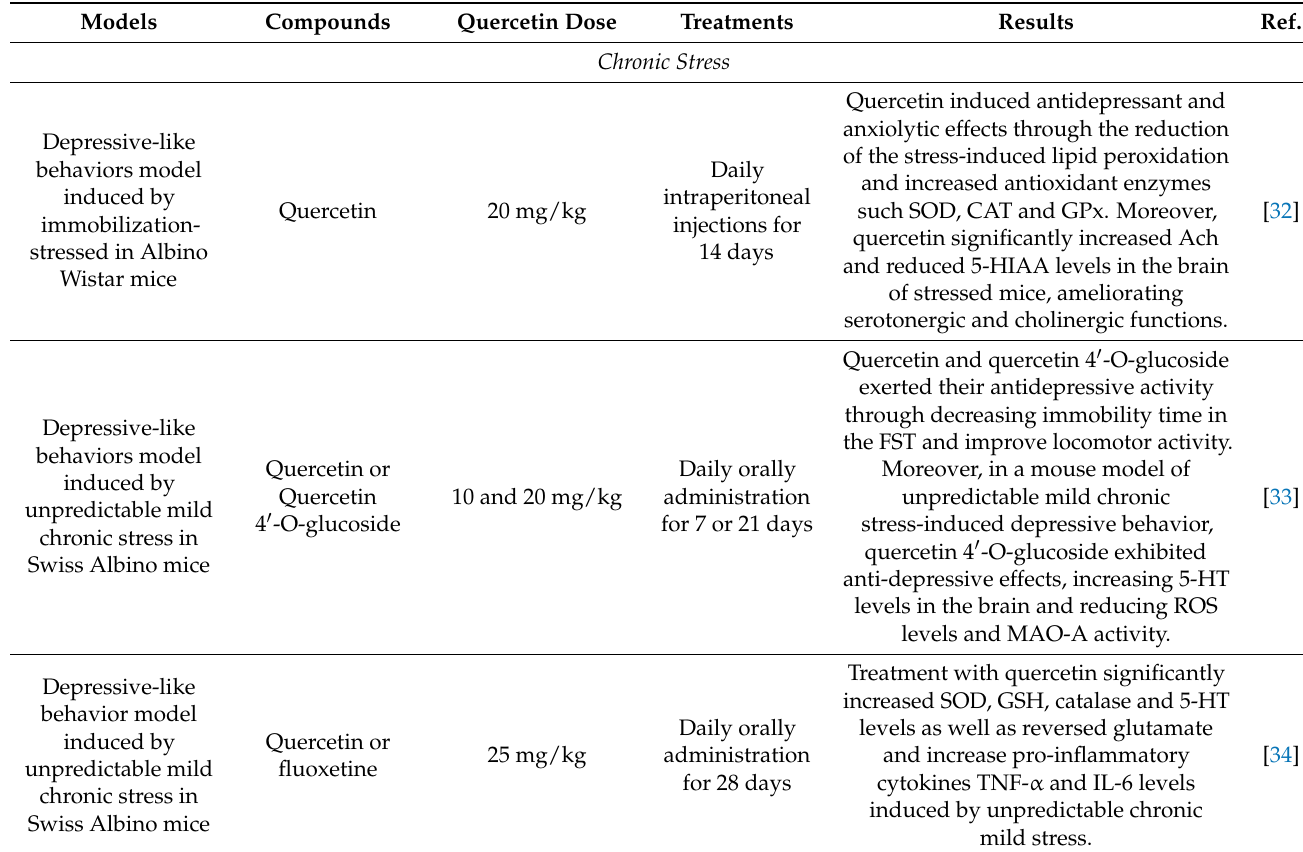
Table 2. Summary of the preclinical studies that evaluate functional properties of quercetin its glycosides in depressive-like behaviors. Specifically, the table lists the animal models used in the studies, used compounds, the type of treatment, the dosage and the obtained